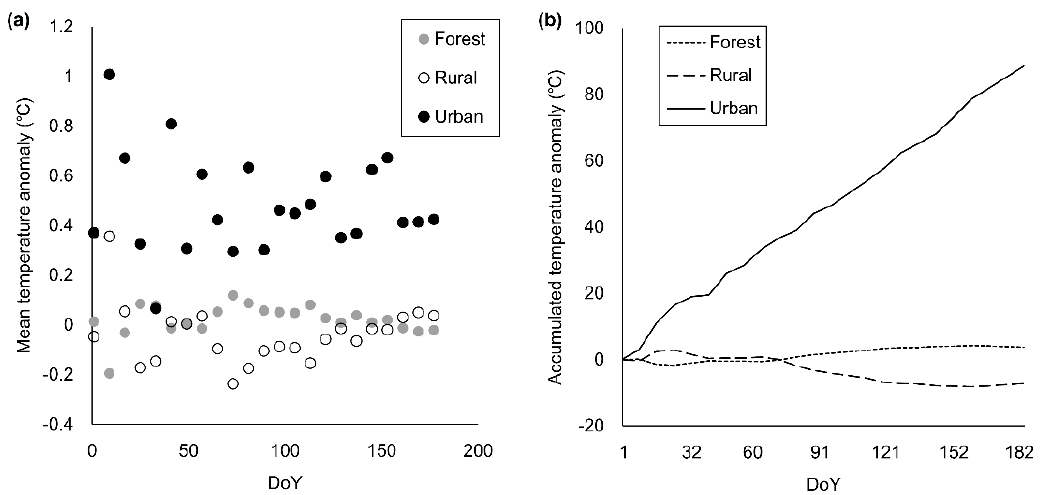
Figure 12. The time-series patterns of the 8-d mean air temperature anomaly ( a ) and accumulated air temperature anomaly ( b ) for land-use types.